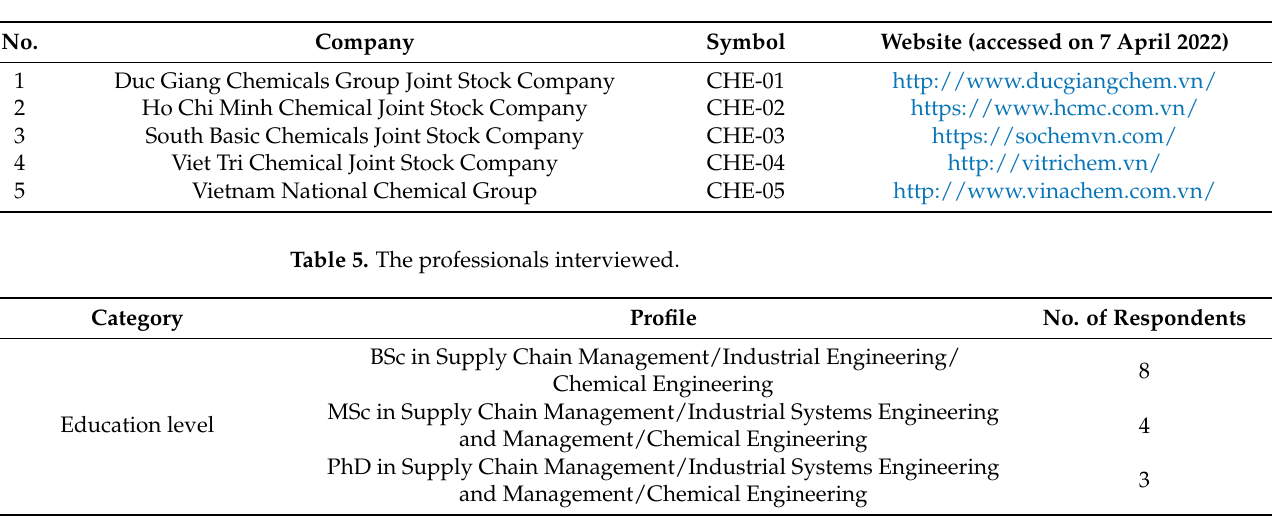
Table 4. The list of suppliers.